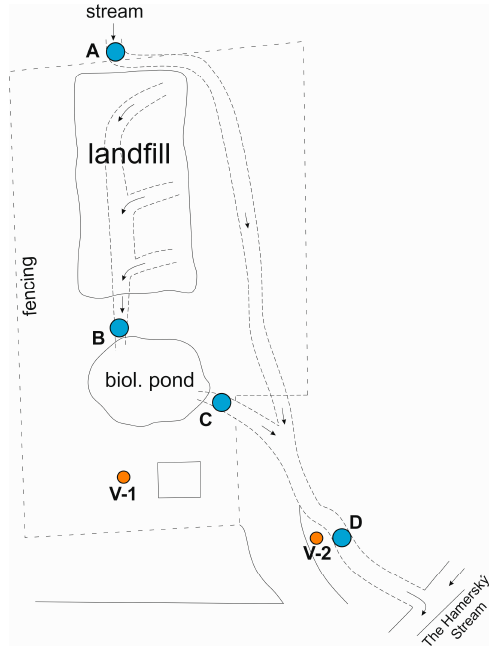
Figure 3. Schematic illustration of the locality with indicated water sampling points.